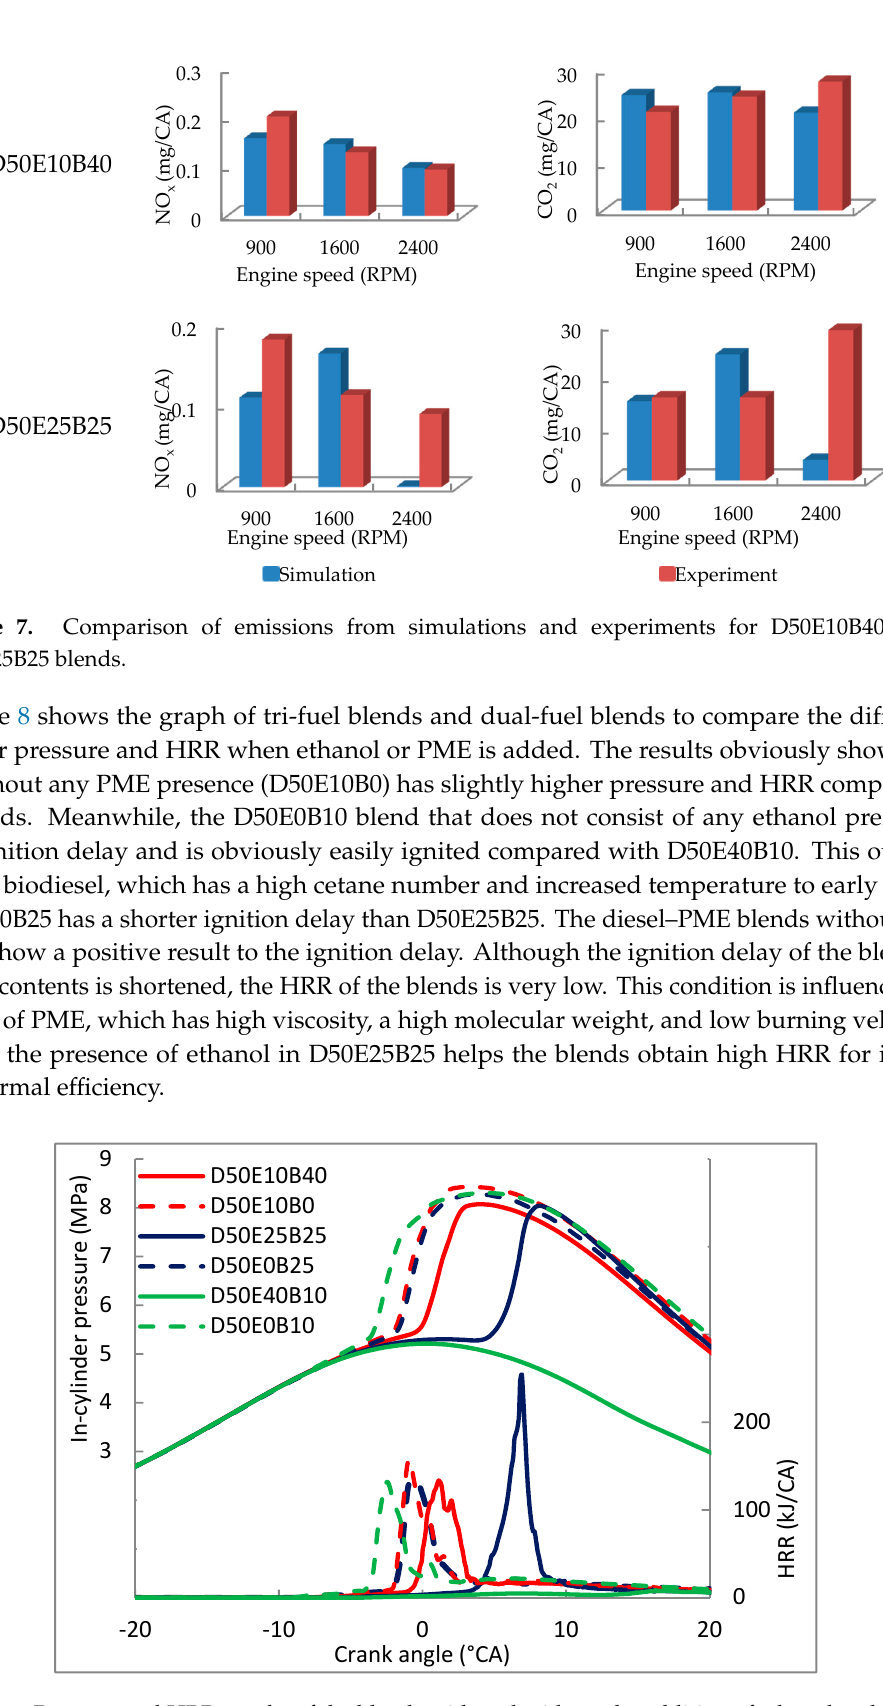
Figure 8. Pressure and HRR graphs of the blends with and without the addition of ethanol and PME.